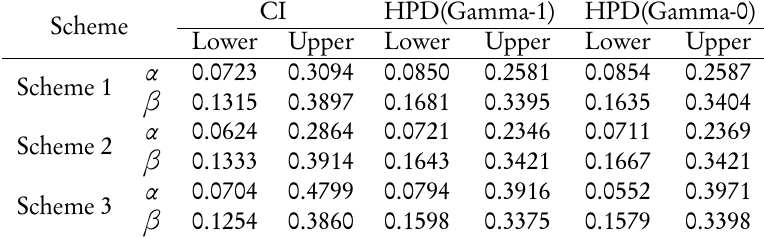
The 95% asymptotic confidence intervals (CI) and HPD credible intervals for real data set.